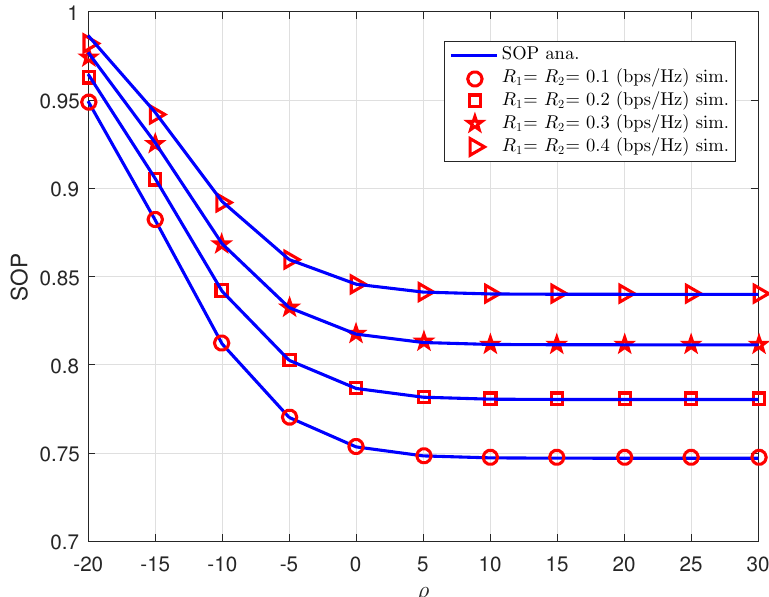
Figure 8. SOP versus ρ for different R 1 = R 2 .